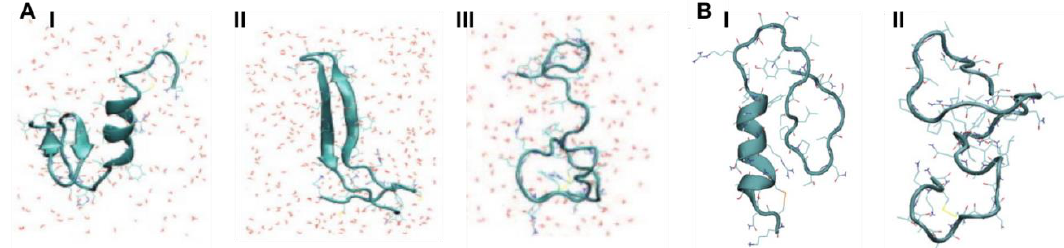
Figure 7. Representative predicted conformations of ( A ) hIAPP: (I) α-helical/coil, (II) anti-parallel β-sheet and (III) random coil conformation adapted from Reddy et al. [69]. ( B ) Representative conformations of rIAPP: (I) α-helical, and (II) random coil conformation. Reddy et al. [68]. Copyright (2010) with permission from Elsevier.